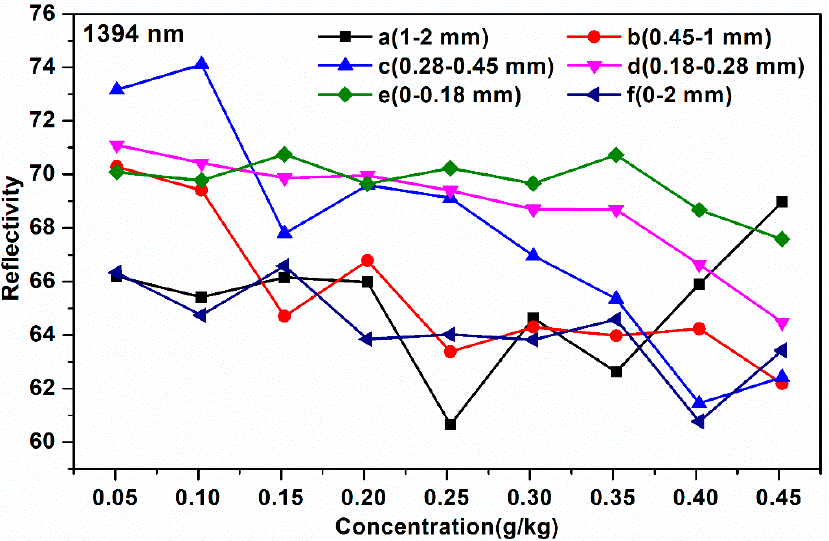
Figure 3. The average spectral reflectivity of soil with different soil particle sizes at 1394 nm: ( a ) 1–2 mm; ( b ) 0.45–1 mm; ( c ) 0.28–0.45 mm; ( d ) 0.18–0.28 mm; ( e ) 0–0.18 mm; ( f ) 0–2 mm.